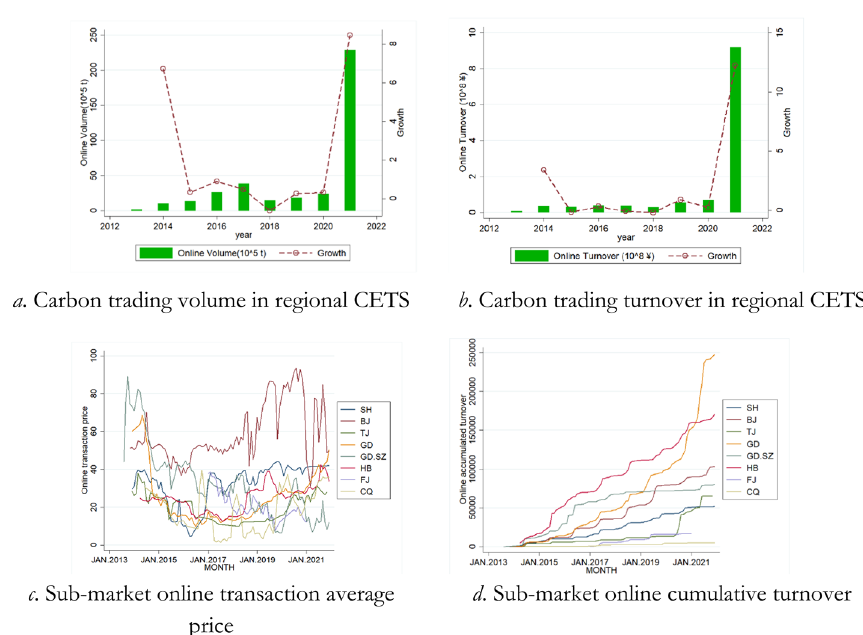
Fig. 1 The transaction situation of China’s regional